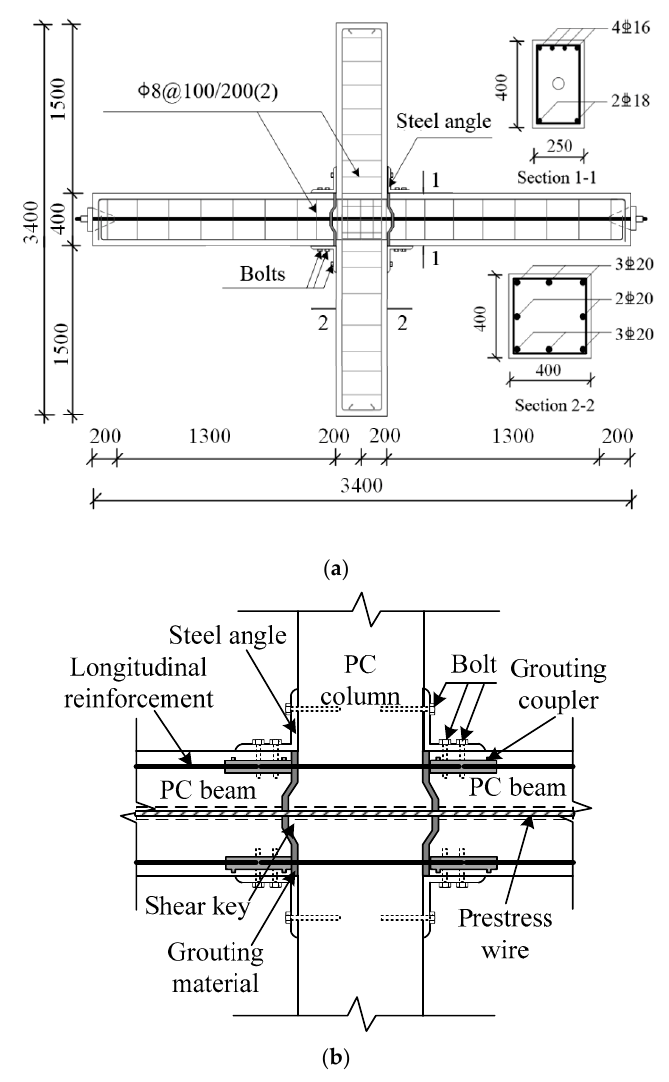
Figure 1. Design dimensions and reinforcement of the HPC connection: ( a ) details of the dimensions and reinforcement of the HPC connection; ( b ) details of the HPC